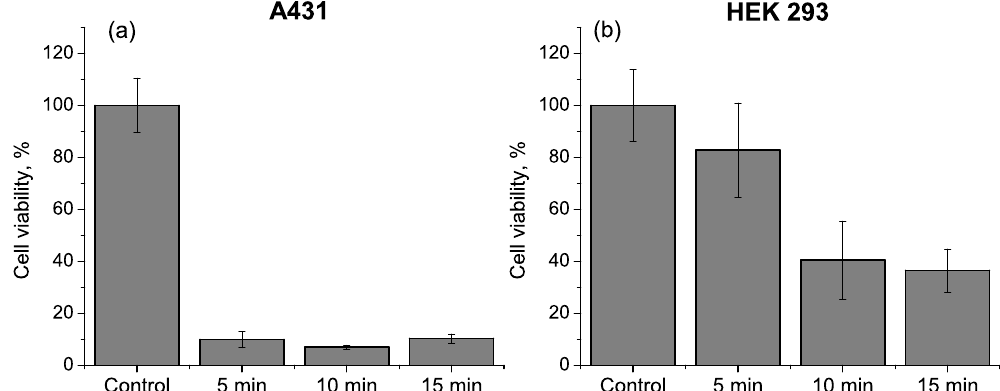
Figure 12. Live cells in % 24 h after the indirect argon CAP treatment of A431 human skin carcinoma ( a ) and HEK 293 human embryonic cells ( b ). Irradiation of media was 5, 10 and 15 min with CAP, without the grounded substrate, at U = 4.9 kV and v = 4 L/min.